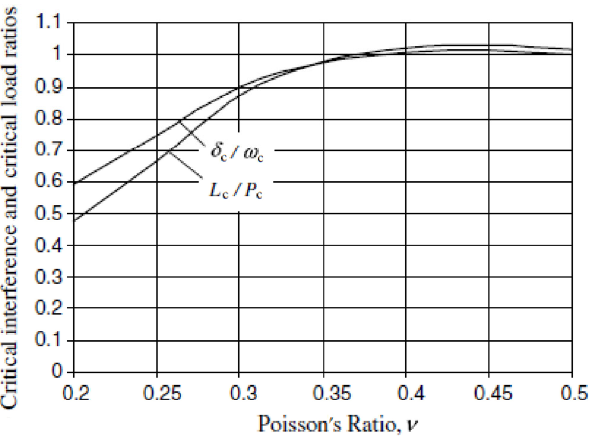
/   , and critical c c Fig. 3 Dimensionless critical load as a function of the dimension- less thickness t / R , for different values of critical loads ratios